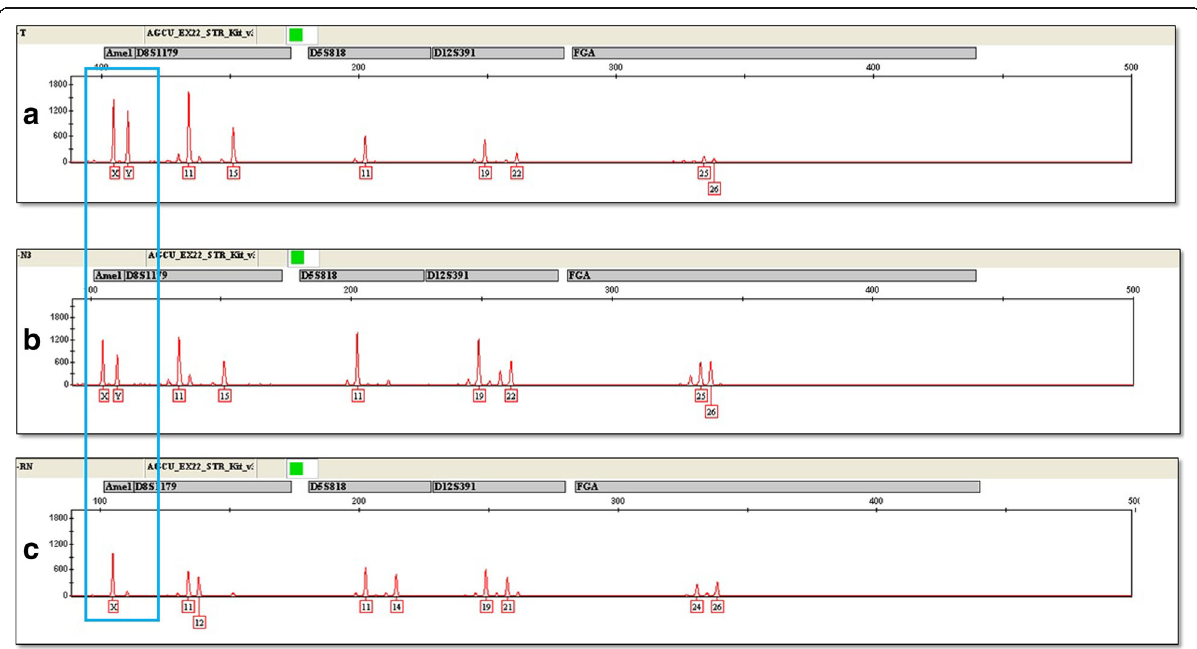
Fig. 4 Short tandem repeat (STR)-based concordance study of the 22 microsatellite markers tested, differences were found between tumor ( a ) and skeletal muscle from the recipient ( c ) in all 22 informative alleles, and a Y chromosome (blue box) was detected, indicating that the MRT was derived from the donor cells ( b